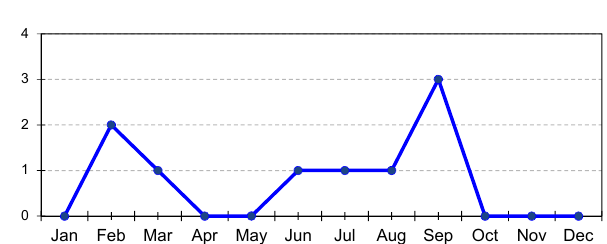
Figure 12. Number of strong Saharan dust event days for each month of the year 2016 over the Palencia AERONET site (Spain) derived from a query to the CÆLIS relational database (see text in Sect.